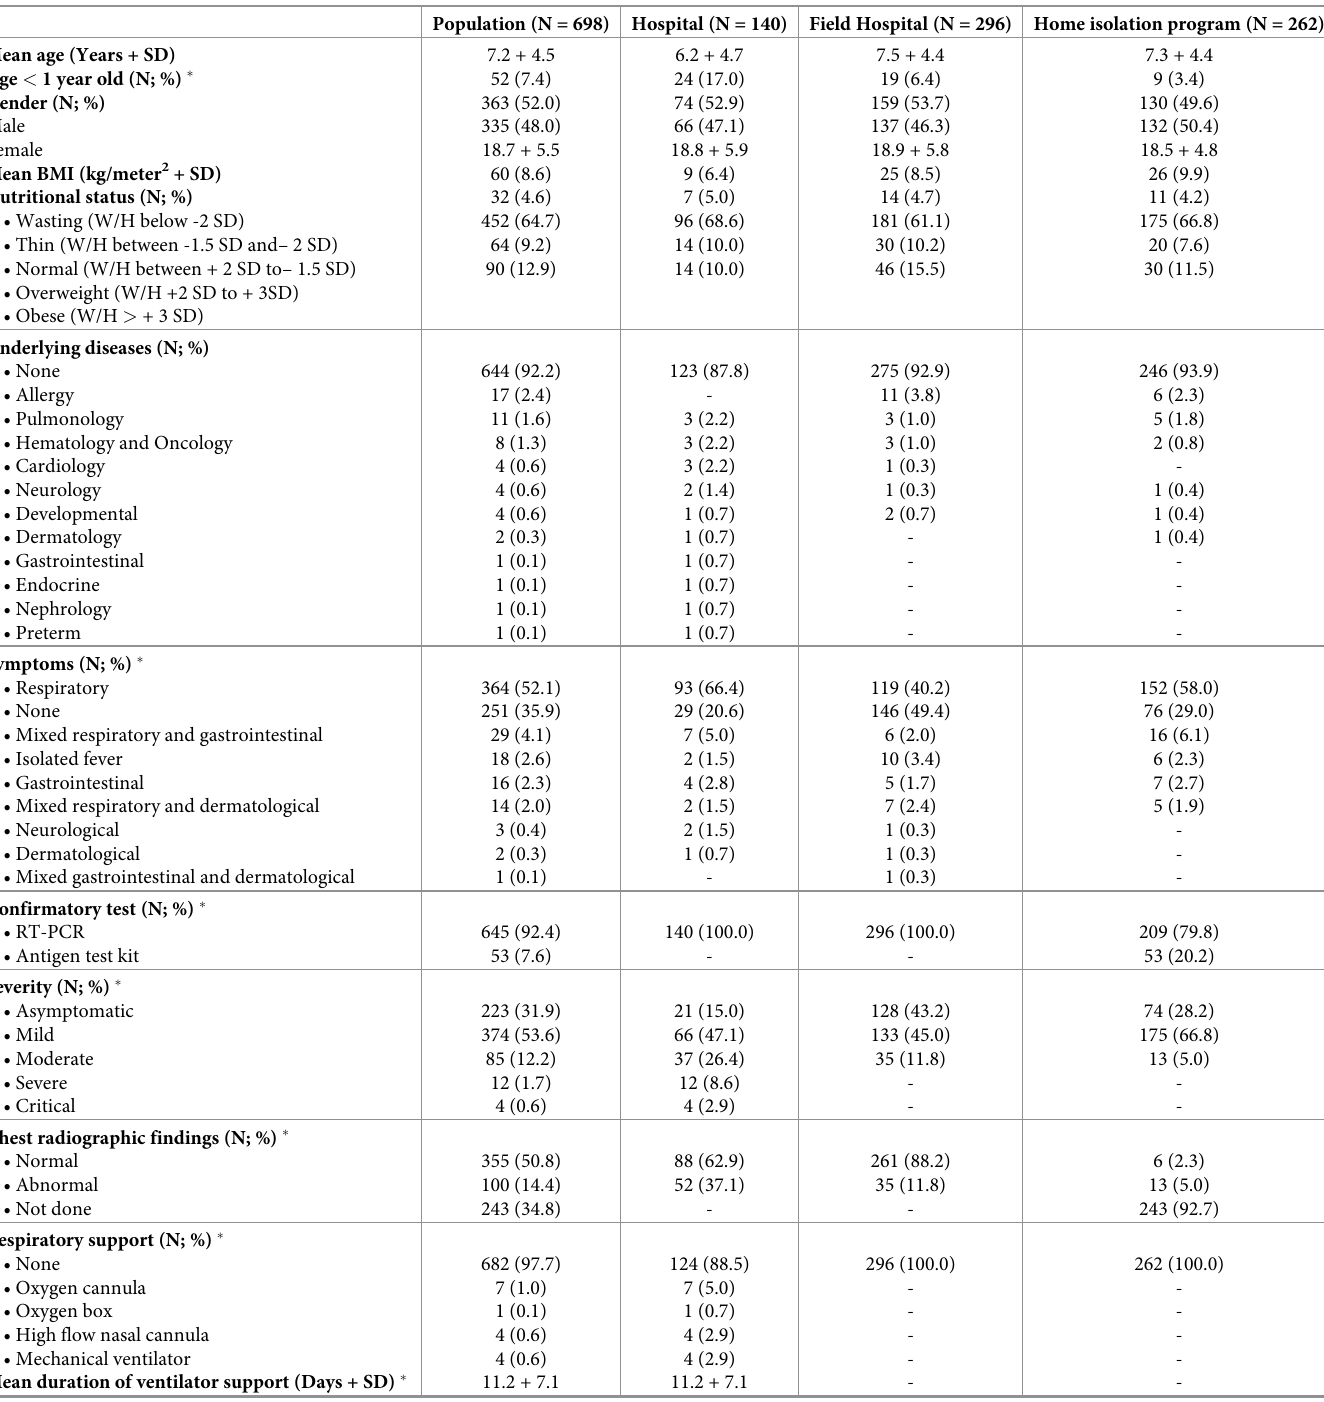
Table 2. Demographic data based on site of